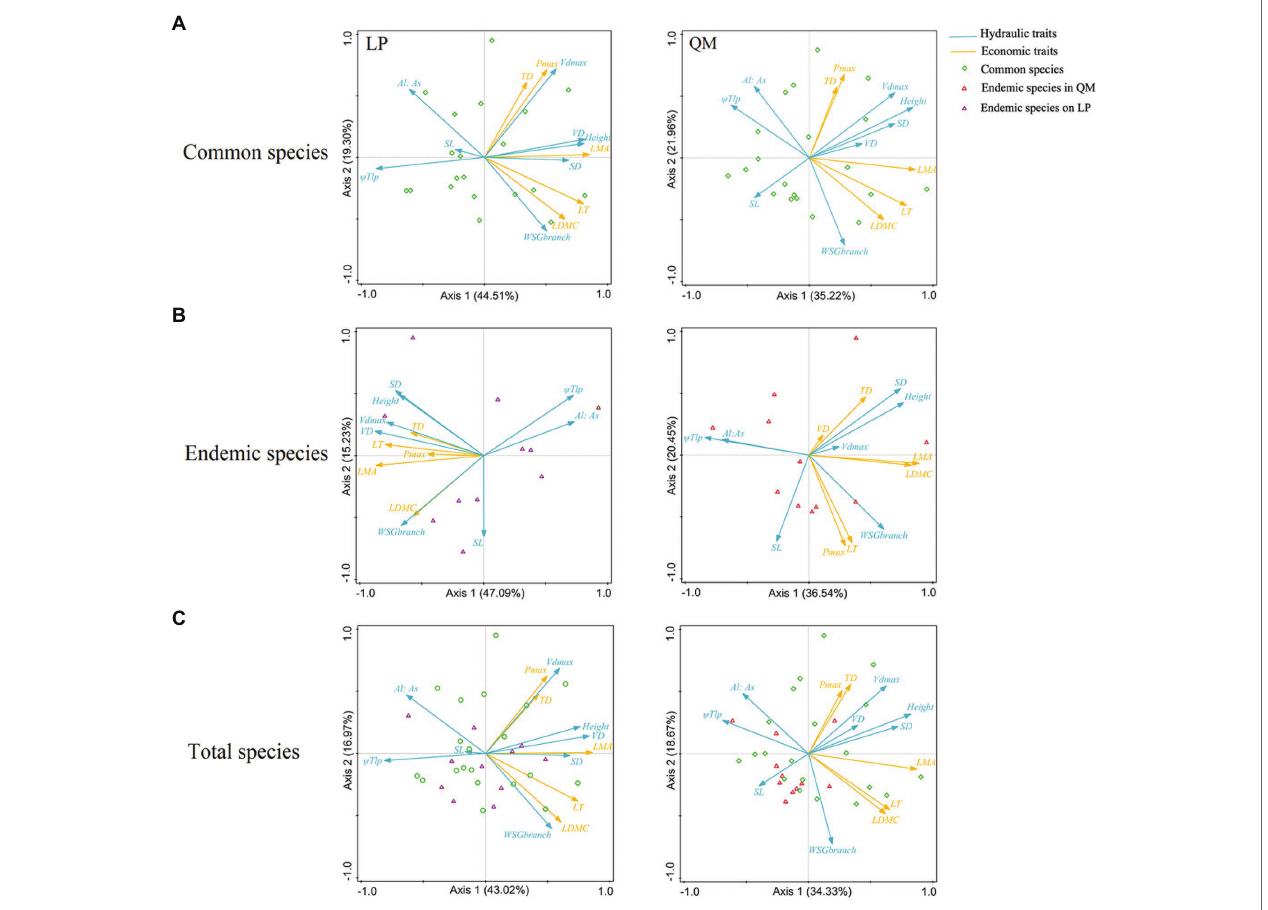
FIGURE 4 | Principal component analysis (PCA) between hydraulic and economic traits on cross-species means among congeneric species (A) (20 pairs of congeneric common species, (B) 11 pairs of congeneric endemic species and (C) 31 pairs of congeneric species). Values in parentheses in the axis labels are percentages explained by the first two components. Eight hydraulic traits were included: SD, stomatal density; SL, stomatal guard cell length; Vd max , maximum vessel diameter; Height; Al:As, leaf area: sapwood area ratio in the branch; VD, vein density; WSG branch , wood specific gravity of branch; Ψ Tlp , turgor loss point. Five economic traits were included: LMA, leaf dry mass per area; LT, leaf thickness; TD, leaf tissue density; LDMC, leaf dry matter content; and P max , maximum net photosynthesis